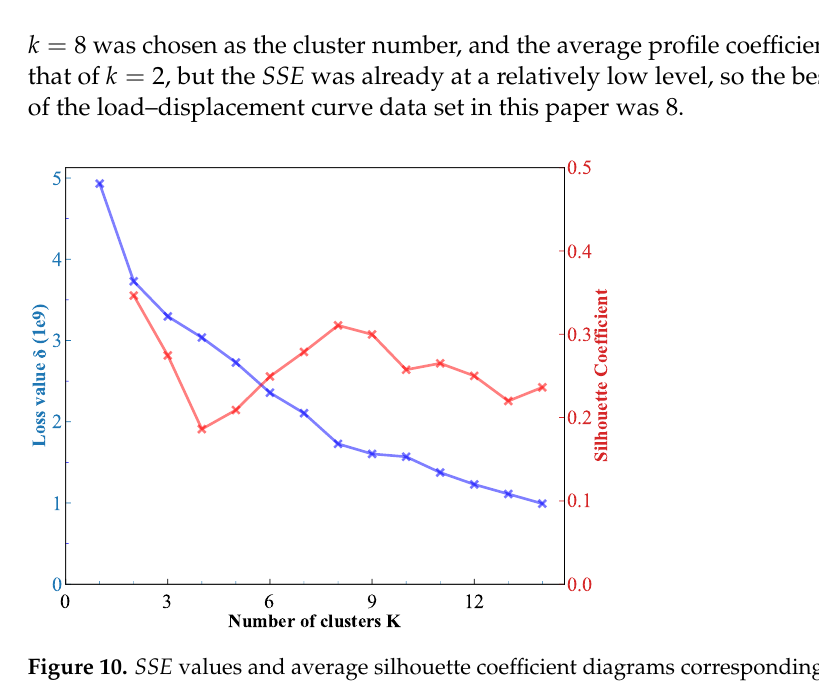
Figure 10. SSE values and average silhouette coefficient diagrams corresponding to different cluster numbers k .